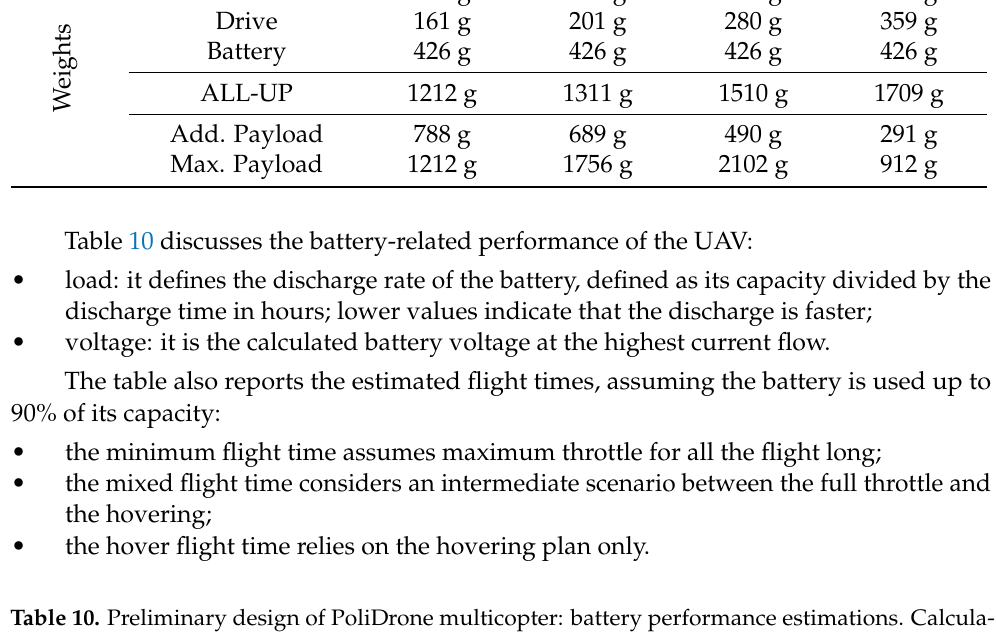
Table 9. Preliminary design of PoliDrone multicopter: frame weights.